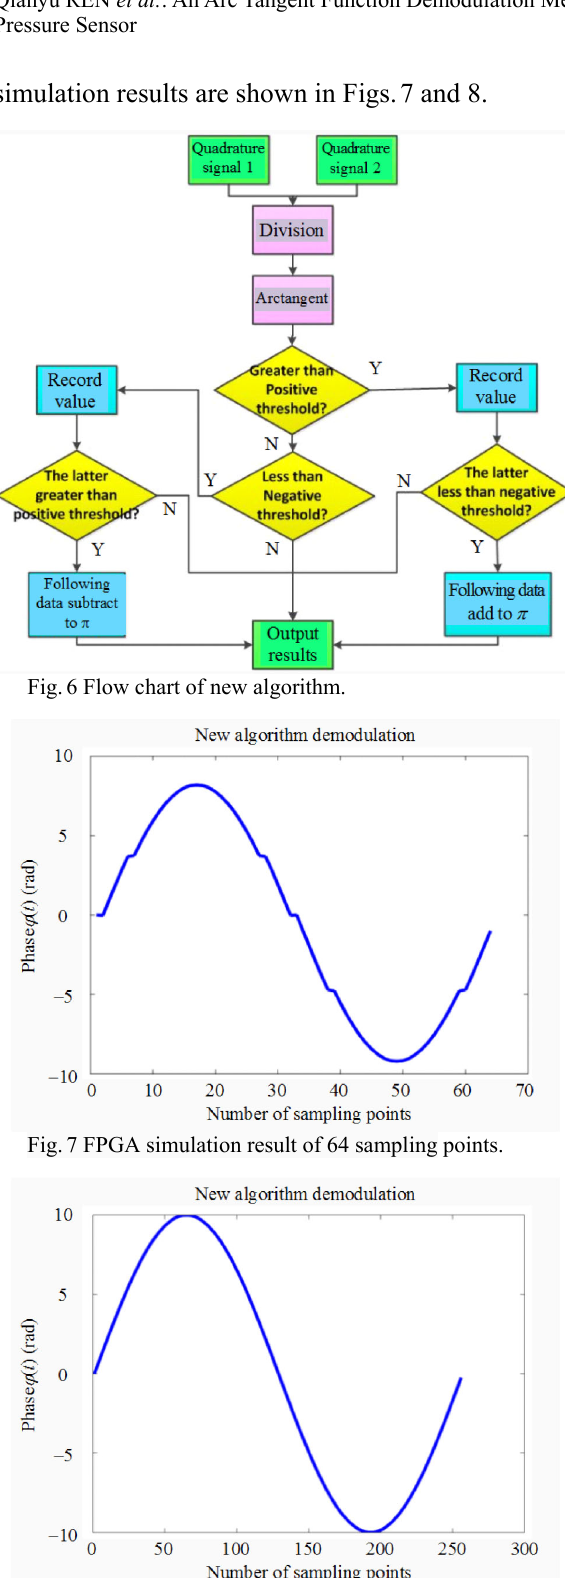
Fig. 8 FPGA simulation result of 256 sampling